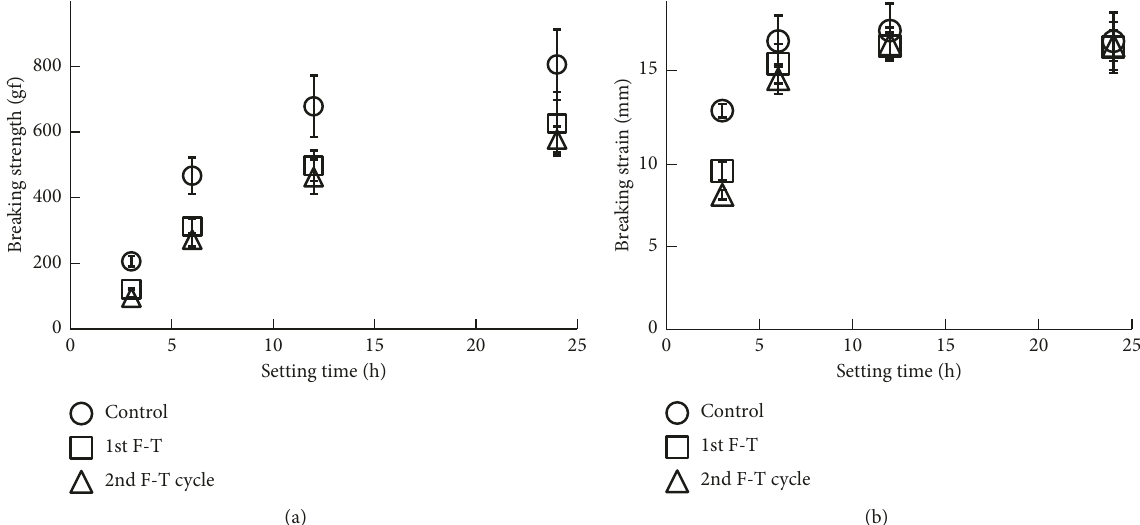
Figure 2: Changes in breaking strength and breaking strain of suwari gel prepared from each frozen surimi during setting time at 20 ° C. Error bar indicates standard deviation.